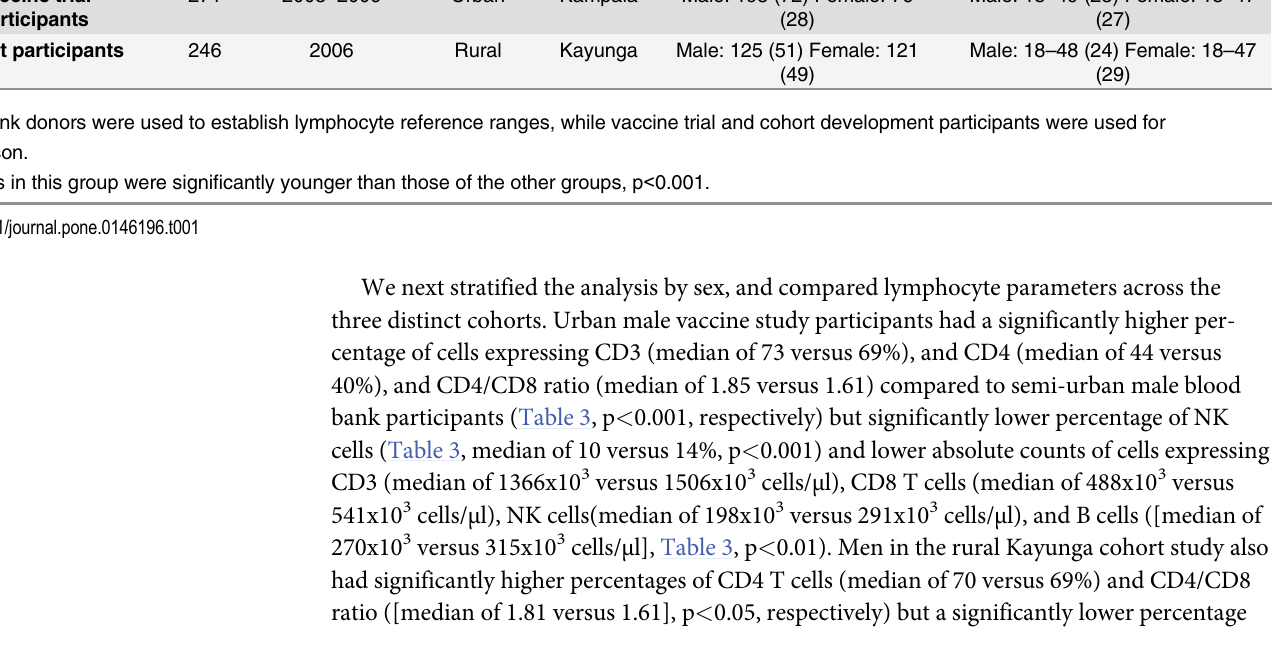
Table 2. Lymphocyte ranges for blood bank donors in Kampala,